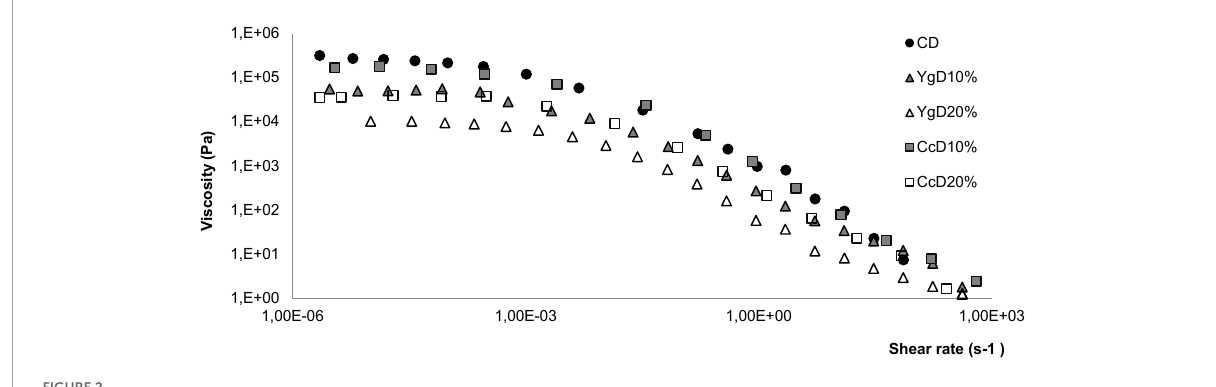
FIGURE2 Flow behavior registered under steady shear conditions, obtained for control dough (CD) and doughs obtained with different levels of Yg (YgD10%, YgD20%) and Cc additions (CcD10%, Cc20%).